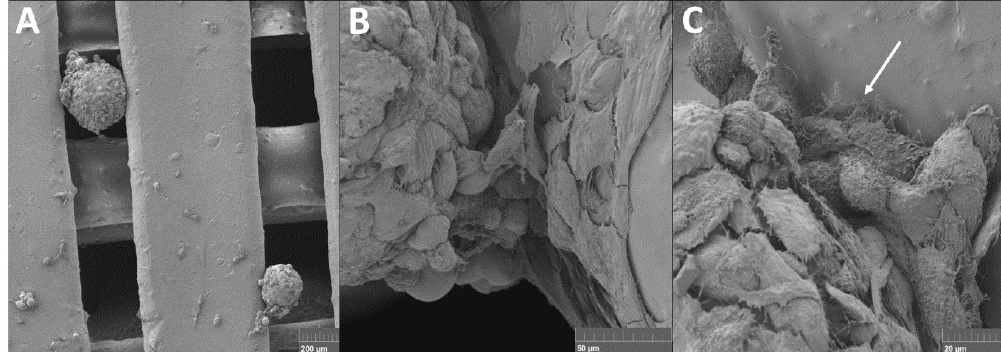
Figure 2. Scanning electron microscope of ASC spheroids associated with 3D PLA/CHA printed scaffold. ( A ) Two spheroids in different areas of scaffold. Bar size: 200 μm; ( B ) Cells of spheroid interacting with the biomaterial surface. Bar size: 50 μm; ( C ) Note the presence of filopodia (arrow) produced by spheroid cells promoting a better interaction with the scaffold. Bar size: 20 μm.